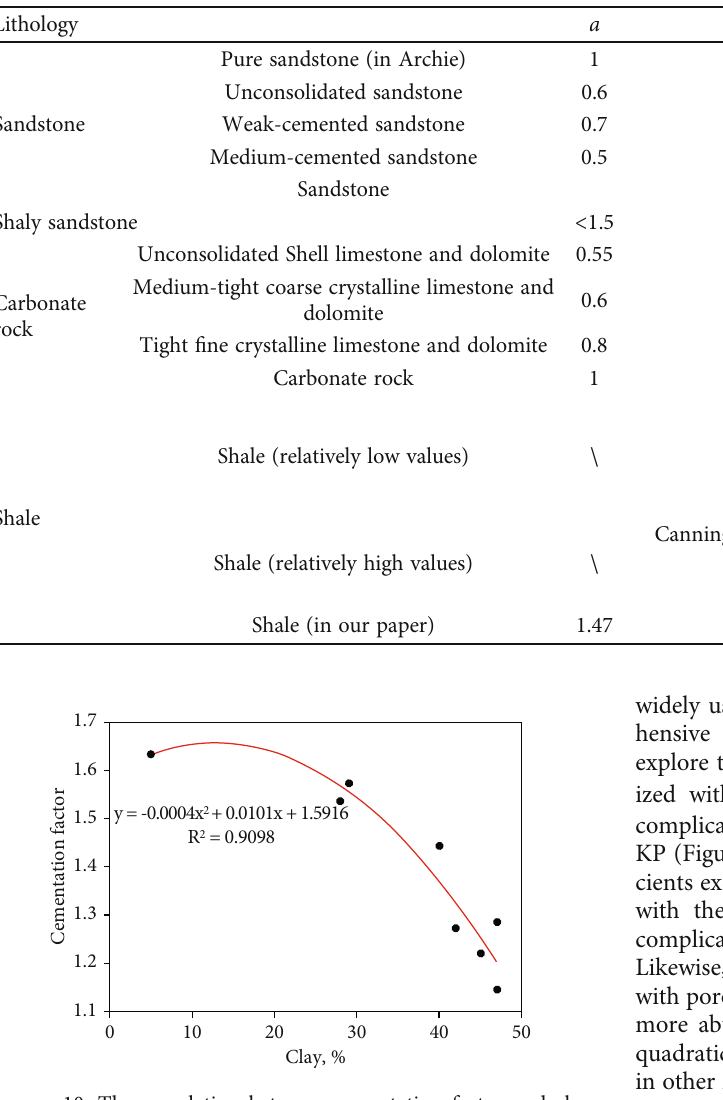
Figure 10: The correlation between cementation factor and clay content ( a = 1